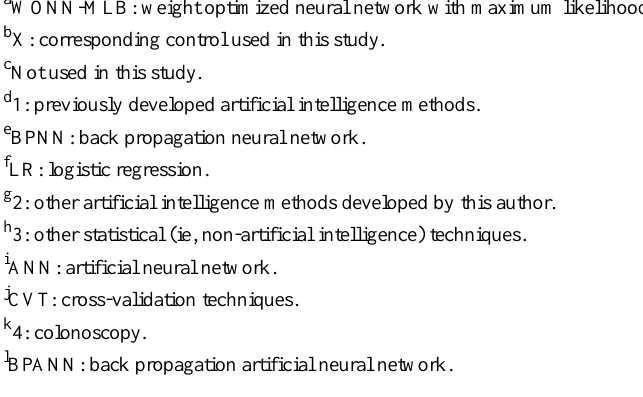
Comparison or controlModality of artificial